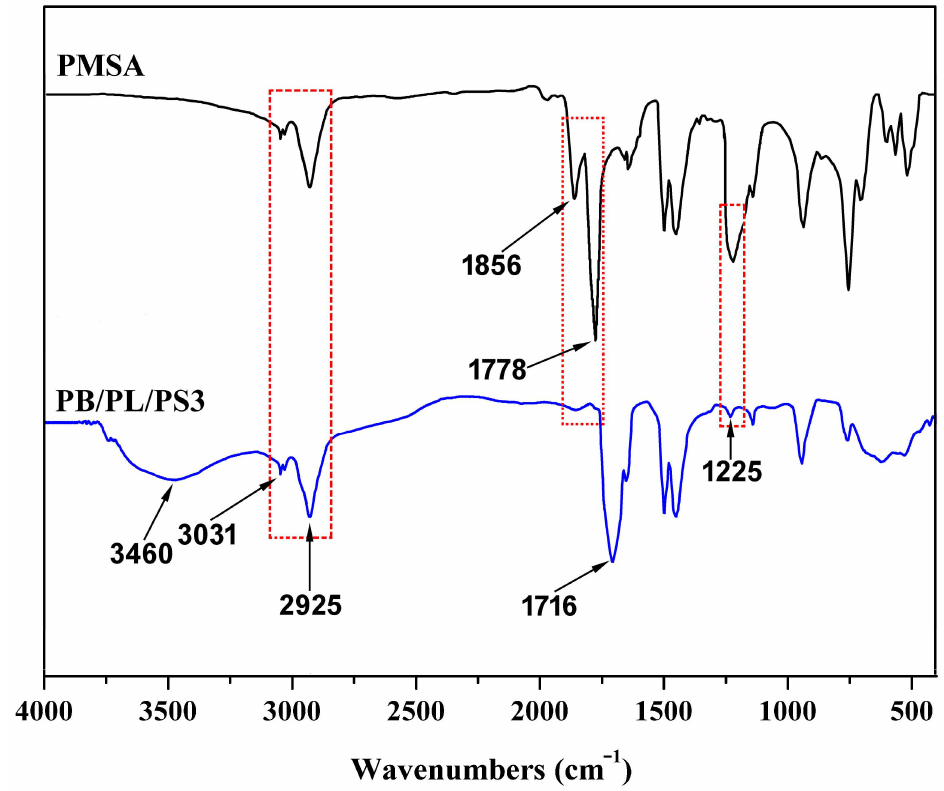
Figure 1. FTIR spectra of PMSA and PBST/PLA